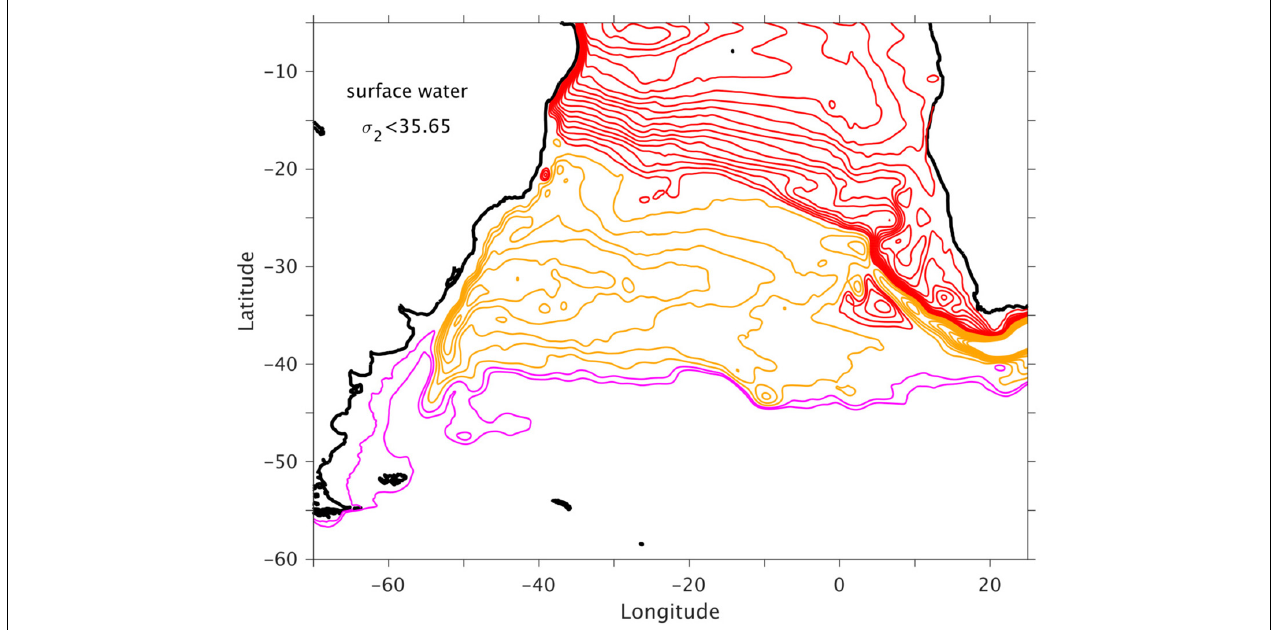
FIGURE 9 | Modeled long-term mean horizontal transport streamfunction (in Sv) for the layer of near surface water ( σ 2 < 35.65 kg m − 3 ). Red and pink streamlines (increment of 1 Sv) denote AMOC contribution and ACC flow; orange streamlines (increment of 2 Sv) denote the subtropical gyre of the South Atlantic.